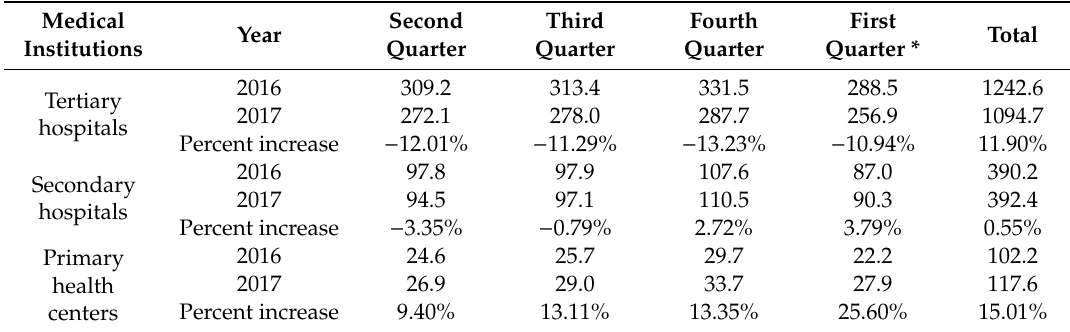
Table 3. The outpatient changes at medical institutions of each level (thousand